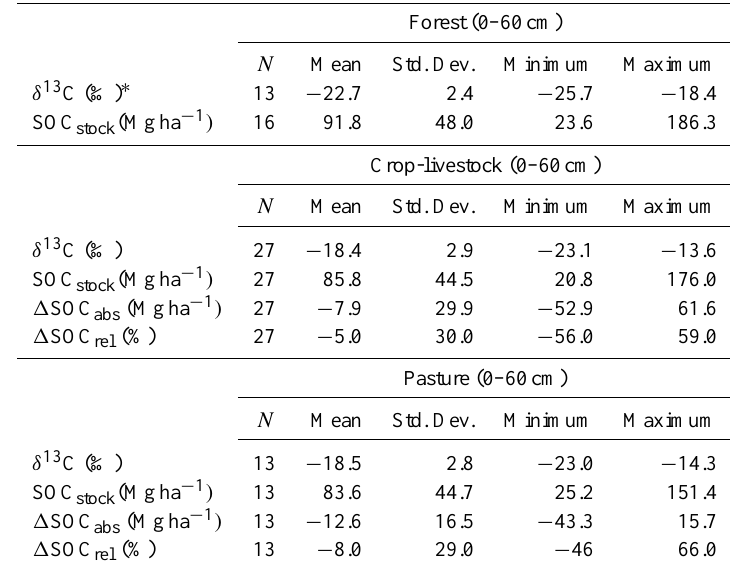
Table 4. Mean, standard deviation (Std. Dev.), minimum and maximum for carbon stocks (SOC stock ) at 0–60cm soil depth layer for forest, crop-livestock systems and pasture soils at paired study sites. 1 SOC abs is the difference between the carbon soil stock of native vegetation and crop-livestock systems and pasture soils obtained in the paired study sites. 1 SOC rel is the same difference expressed as percentage. Carbon losses are indicated by a minus sign (–).